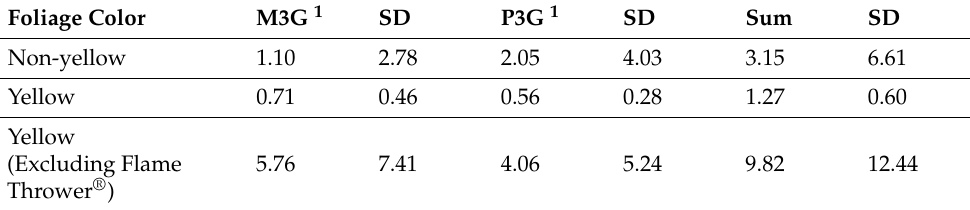
Table 5. Concentration of malvidin-3-glucoside, peonidin-3-glucoside, and total anthocyanin in petiole tissue of Eastern redbud ( Cercis canadensis L.) with yellow and non-yellow foliage. Foliage Color M3G 1 SD